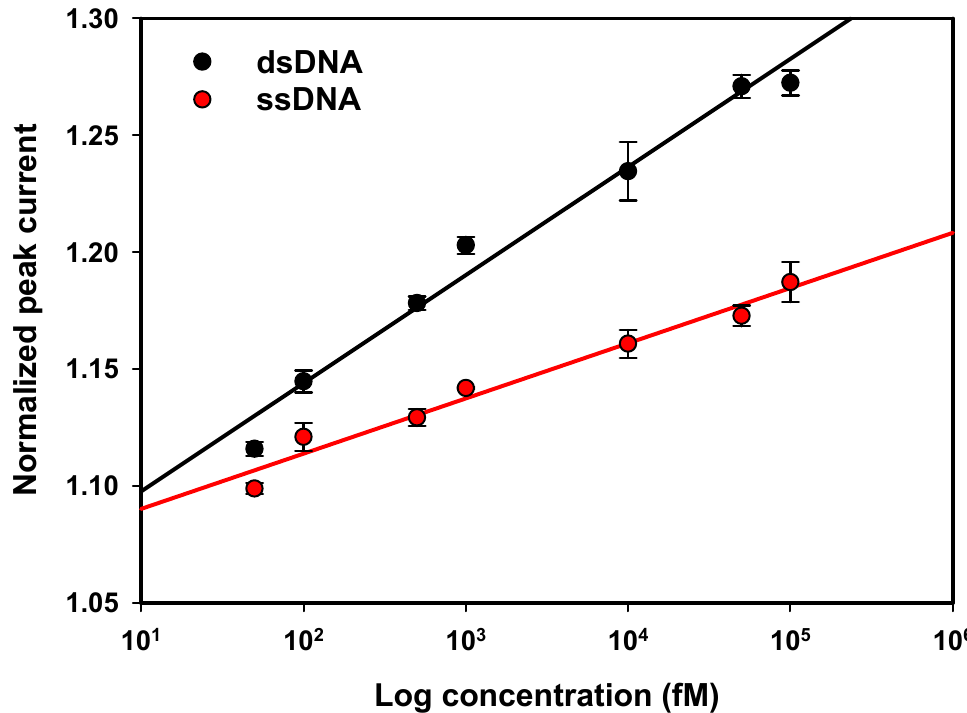
Figure 5. Calibration curves constructed with normalised peak currents of DPV responses as a function of the logarithm of the concentration of target ssDNA (red) and dsDNA (black). For both targets, the current increases with increases in concentration. Error bars are the standard deviation of three